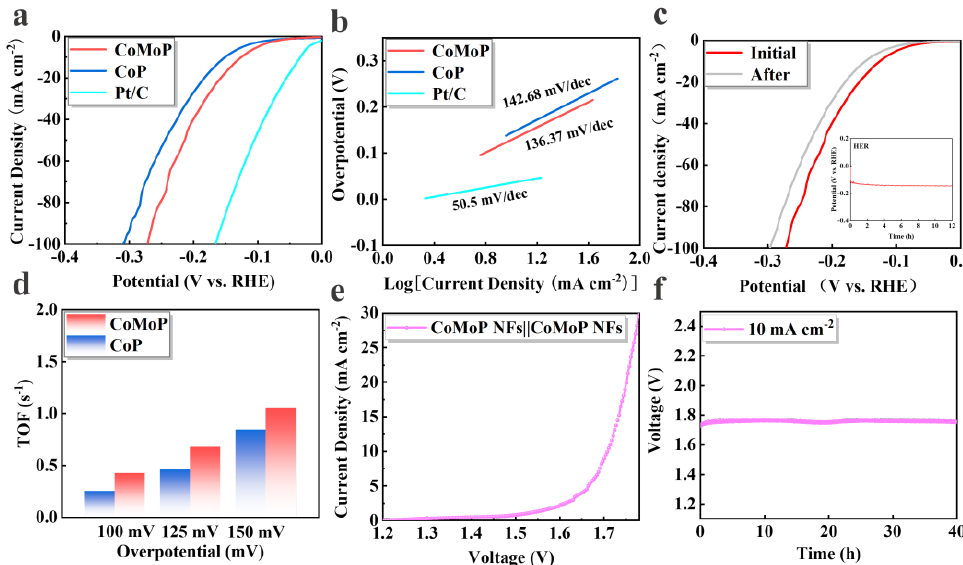
Figure 5. ( a ) LSV curves of Pt/C, CoMoP and CoP NFs. ( b ) Corresponding HER Tafel plots. ( c ) The long-term stability of CoMoP nanofibers for 4000 CV cycles and chronopotentiometry tests at a current density of 10 mA cm − 2 . ( d ) Corresponding TOF values of CoMoP and CoP NFs. ( e ) LSV curves for CoMoP NFs||CoMoP NFs electrolyzers in 1 M KOH in a two-electrode configuration. ( f ) The curves for the chronopotentiometry tests for CoMoP NFs||CoMoP NFs at a current density of 10 mA cm − 2 .